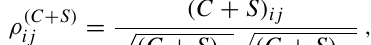
Fig. 5 Comparison of the diagonal experimental uncertainties (blue) and the diagonal theoretical uncertainties evaluated using the 9-point prescription (red), all normalized to the central experimental value. The